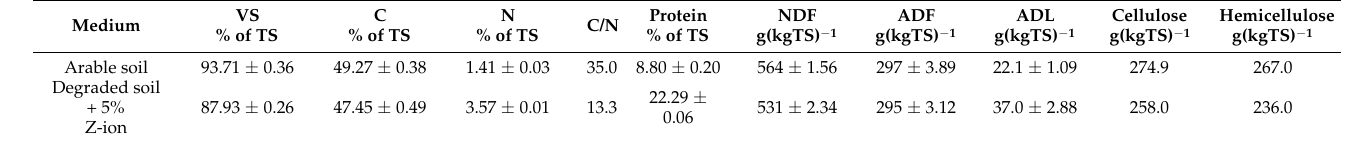
Table 5. Chemical composition of the maize biomass used in the batch digestion test.